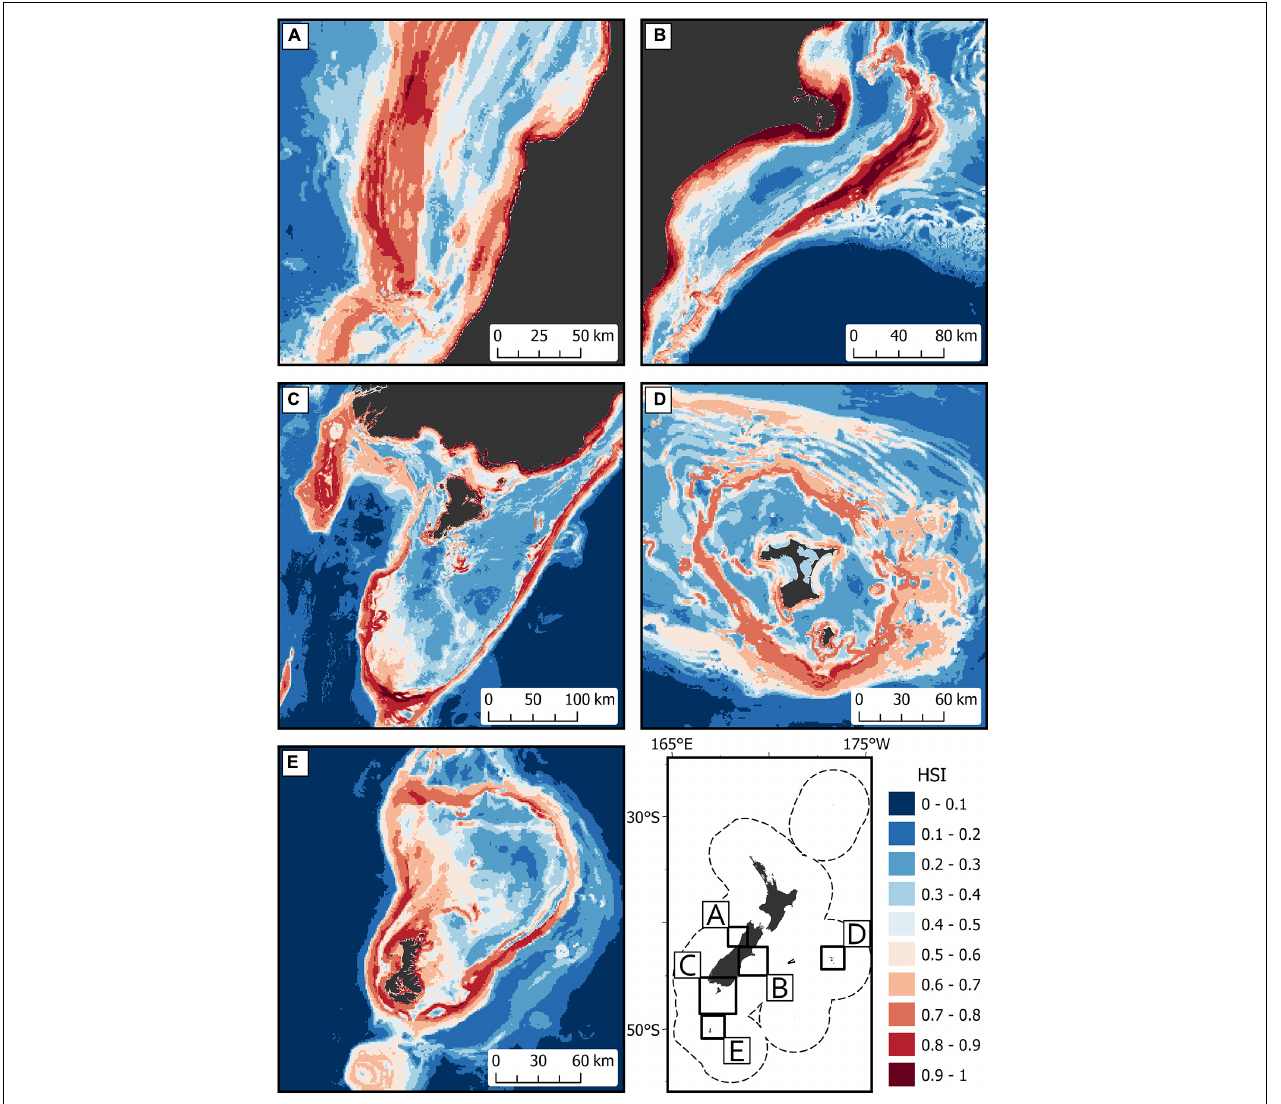
FIGURE 3 | The predicted habitat suitability index (HSI) of basking shark in the New Zealand Exclusive Economic Zone (EEZ) from 1889 to 2020 modeled using the bootstrapped ensemble models for (A) west coast South Island; (B) east coast South Island; (C) south of South Island including Puysegur Ridge and Stewart Island; (D) Chatham Islands; and (E) Auckland Islands. Areas outside 95% kernel density estimate (KDE) probability grid indicating lower confidence that can be placed in the predicted probability occurrence are covered by crossed black lines. Note that the Chatham Islands (D) is outside the KDE probability grid